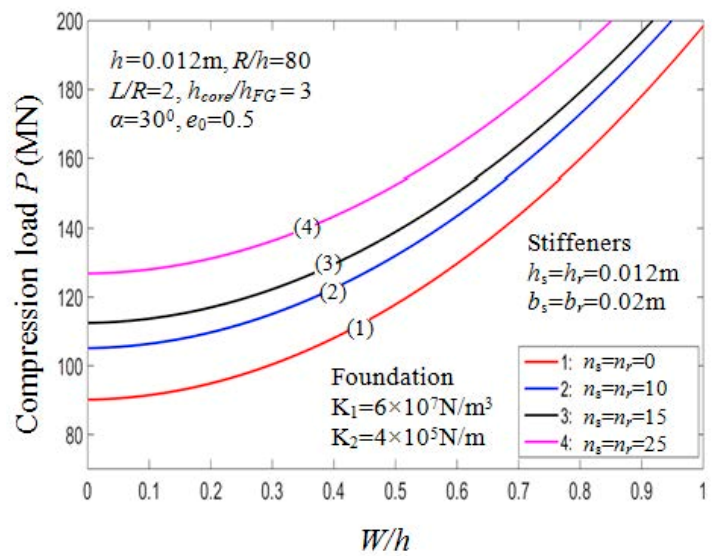
Materials 2018 , 11 , x FOR PEER REVIEW Figure 12. Effects of stiffeners on postbuckling load—deflection curves (Case 1, k 2 = k 3 = k = 1).